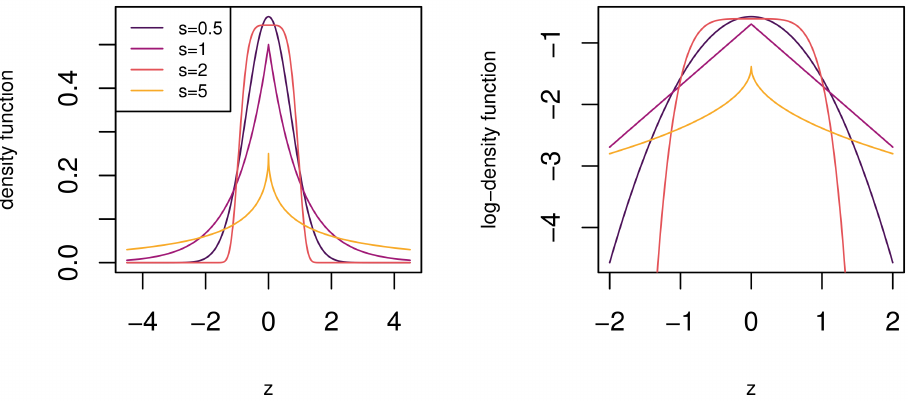
Figure 1. The generalized normal (GN) density function for different values of s . The GN density function is relatively heavy-tailed for values of s < 2 and light-tailed for values s >